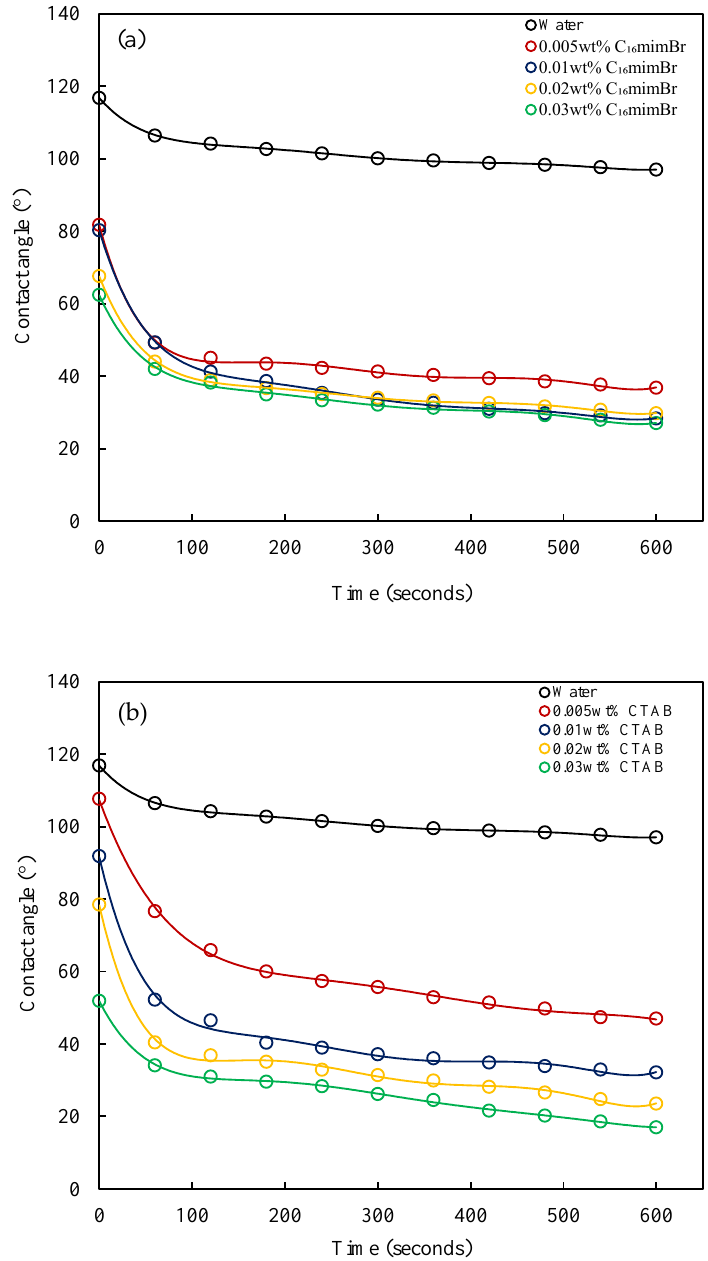
Figure 12. The dynamic contact angle of ( a ) C 16 mimBr and ( b ) CTAB on a carbonate surface.